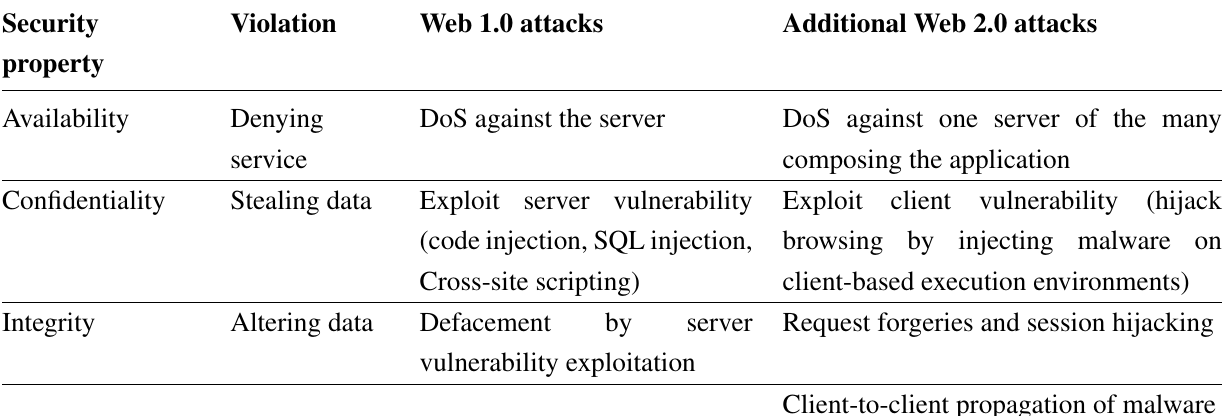
Table 1. A summary of Web 1.0 and Web 2.0